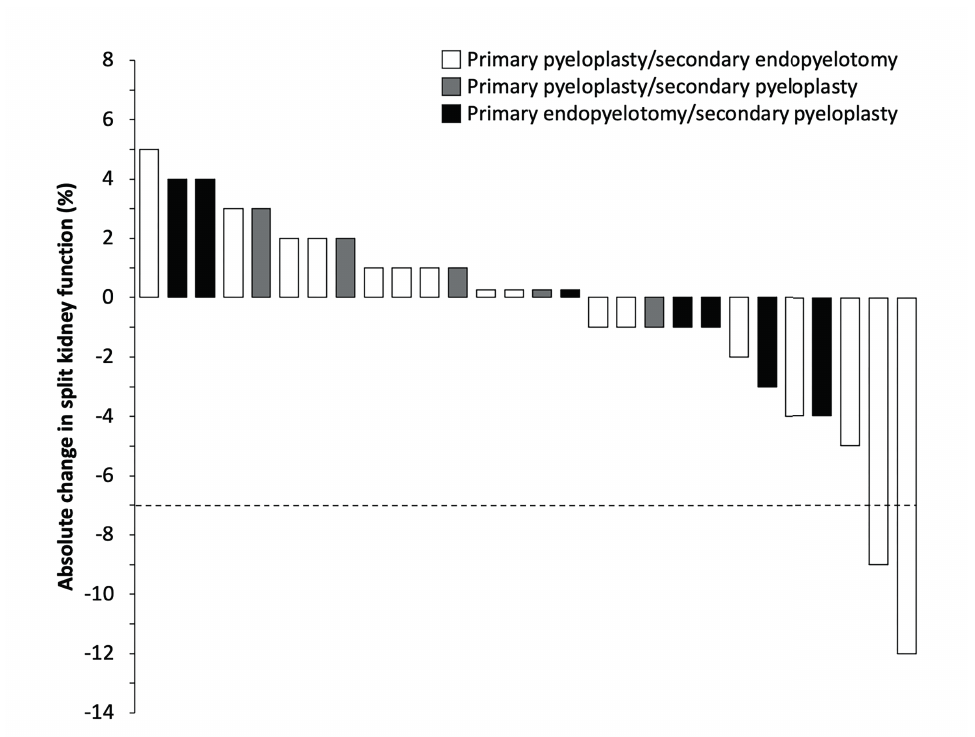
Figure 2 - Waterfall plot of interval change in split kidney function for 28 patients who underwent diuretic renography both before and after salvage interventions. The dashed line at -7% corresponds to the selected defi nition of a signifi cant decrease in split kidney